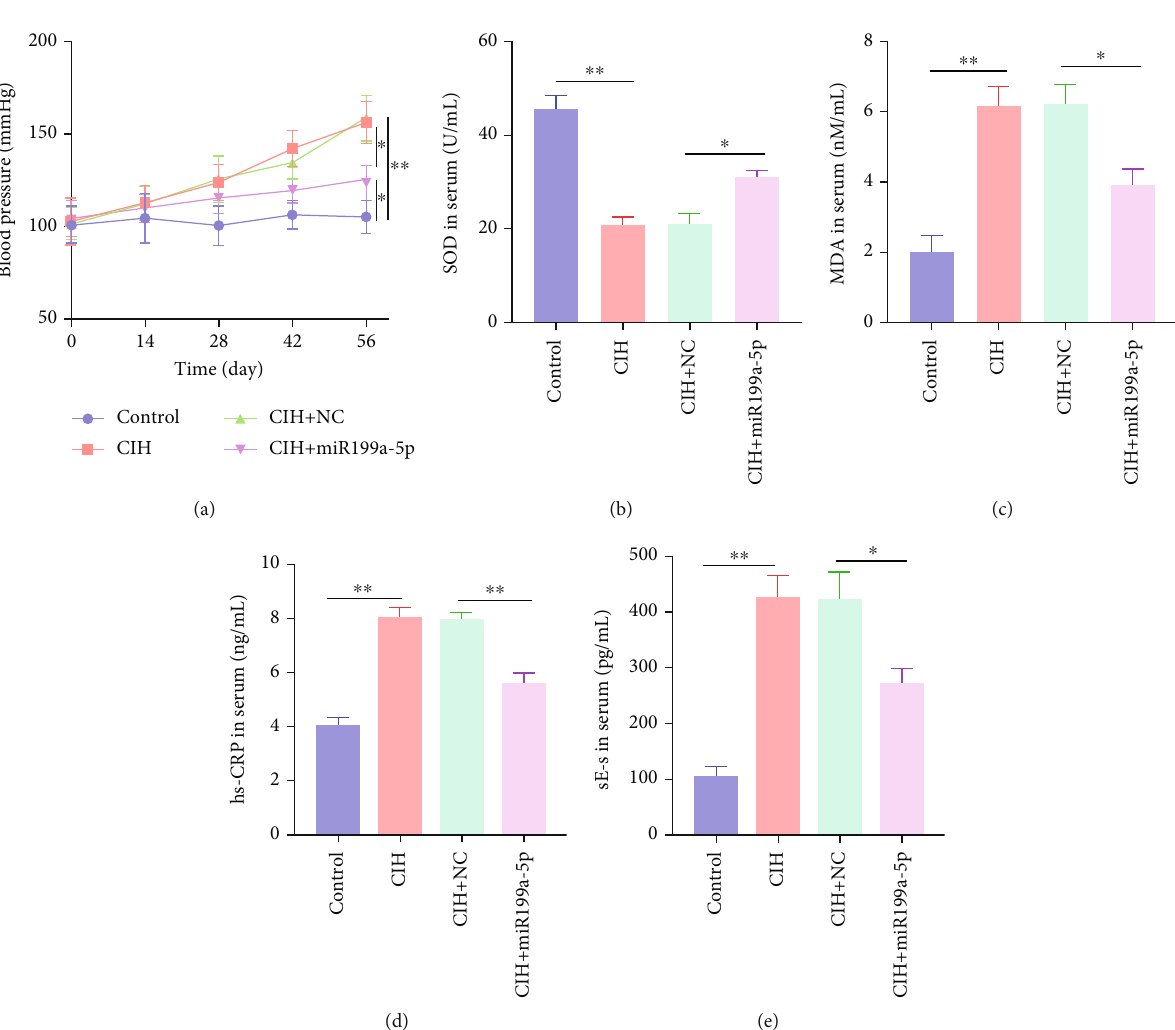
Figure 2: Overexpressed miR-199a-5p reduces blood pressure and relieves oxidase stress and in fl ammation. (a) Blood pressure in rats with exposure to CIH during 56 days. (b) SOD, (c) MDA, (d) hs-CRP, and (e) sE-s in serum of rats in control, CIH, CIH+NC, and CIH+miR- 199a-5p groups. CIH: chronic intermittent hypoxia. ∗ P < 0 : 05 , ∗∗ P < 0 : 01